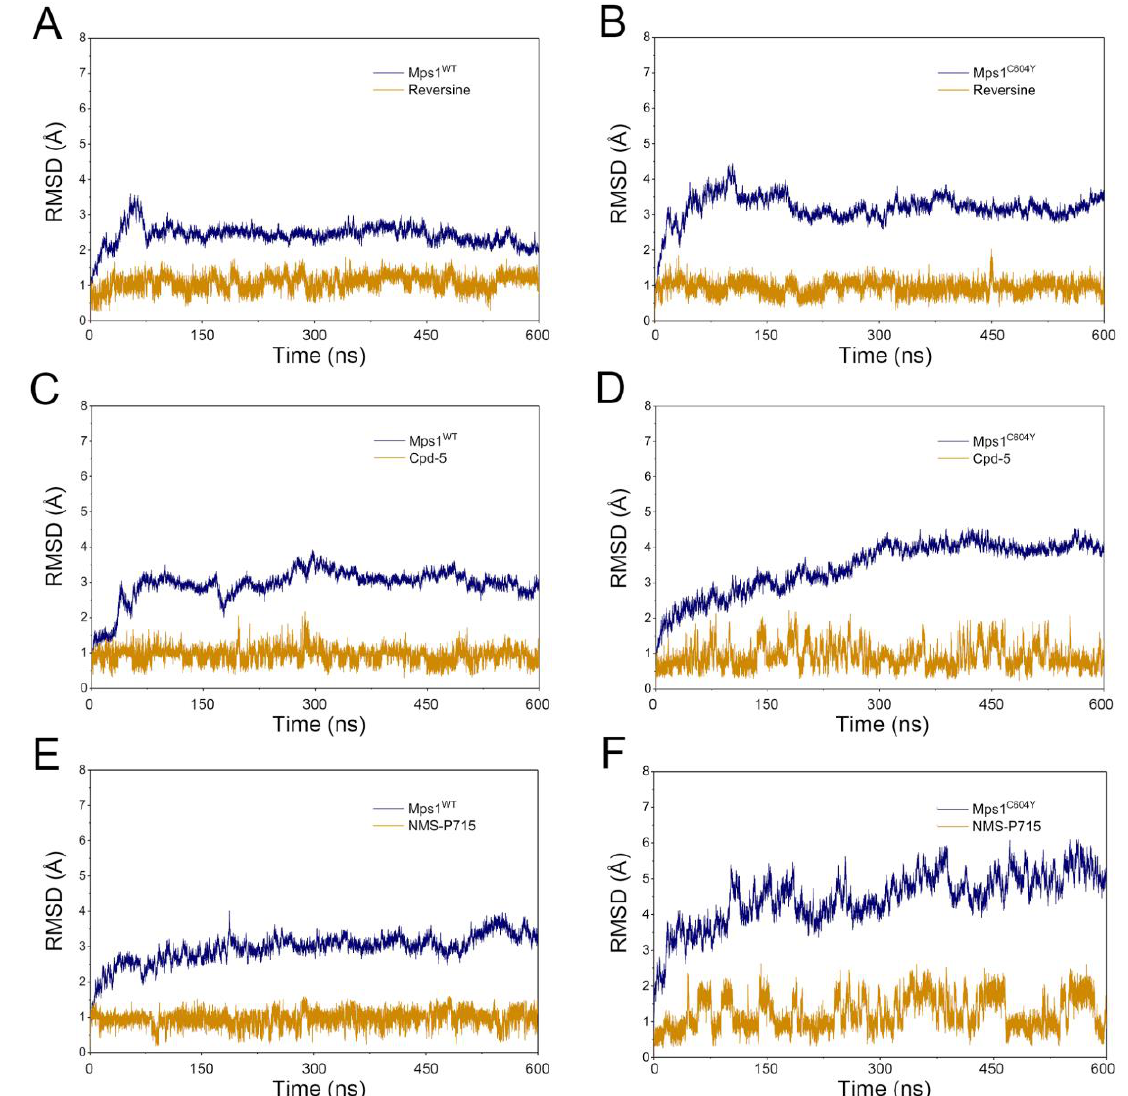
Figure 6. RMSD analysis of reversine, Cpd-5 and NMS-P715 in Mps1 WT and Mps1 C604Y from accelerated molecular dynamic (aMD) simulations. ( A ) Mps1 WT /reversine; ( B ) Mps1 C604Y /reversine; ( C ) Mps1 WT /Cpd-5;